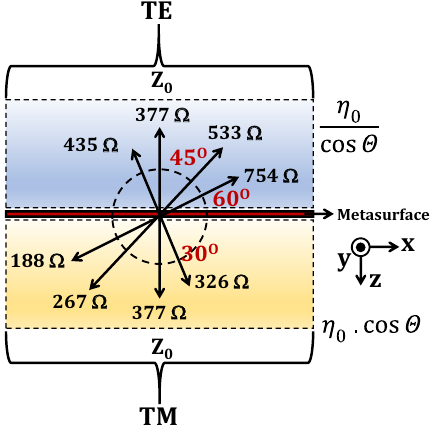
Figure 12. Sensitivity of asymmetric transmission at oblique incidences illustrated through the concept of increasing impedance mismatch at higher angles.